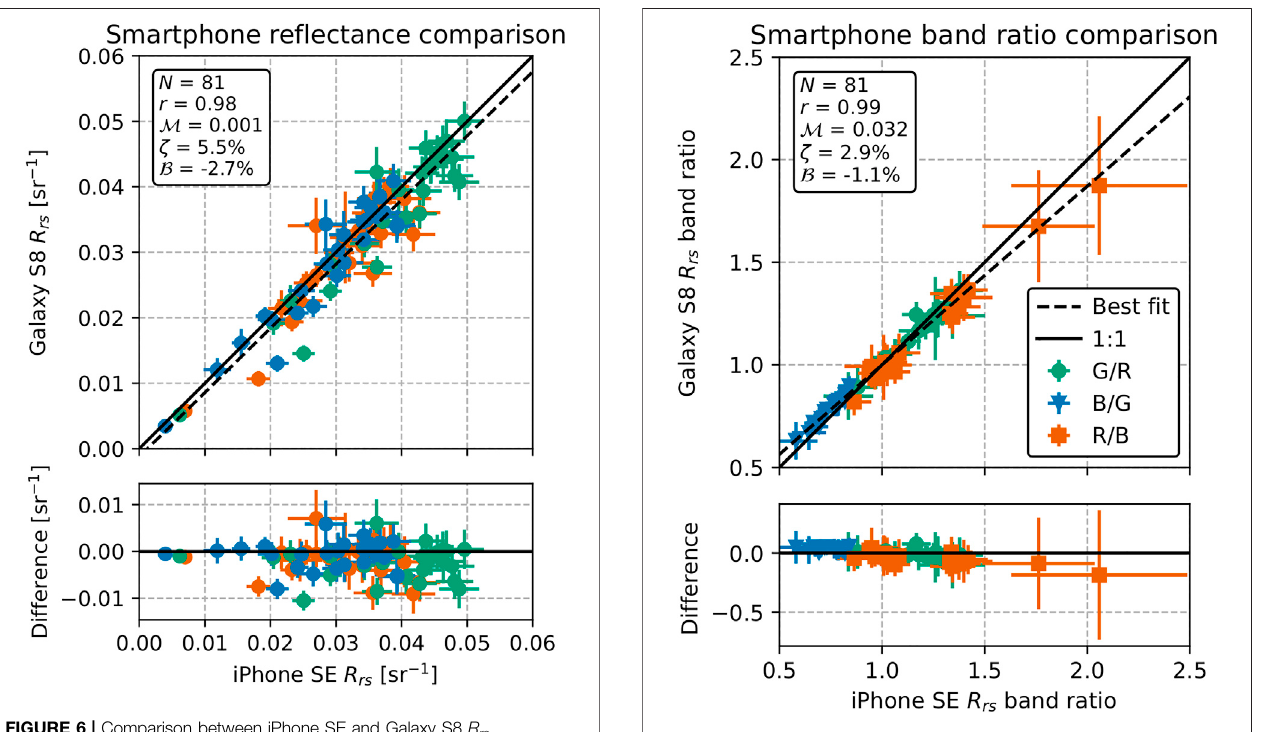
FIGURE 7 | Comparison between iPhone SE and Galaxy S8 R rs band ratios. The solid line corresponds to a 1:1 relation, the dashed line is the best- fi tting linear regression line. The statistics in the text box are based on a 1:1 comparison, as are the differences in the lower panel.